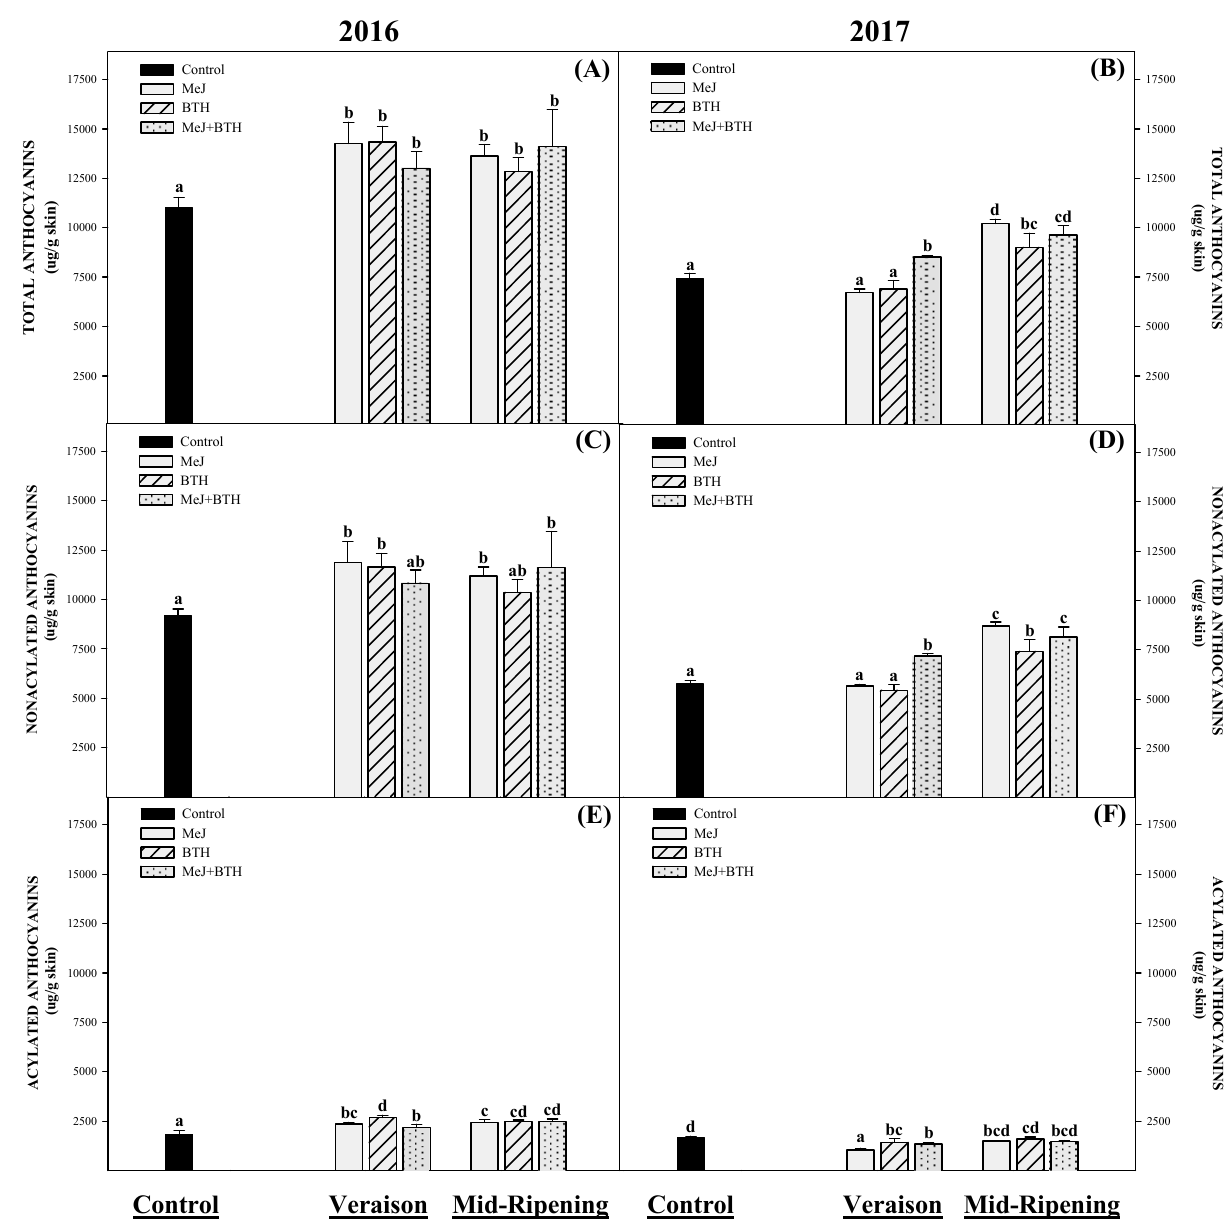
Figure 1. Concentration of anthocyanins measured by HPLC in Monastrell grape berry skin following treatment with MeJ, BTH, and MeJ + BTH applied on two different times: veraison and mid-ripening. Different letters indicate significant differences according to Duncan’s test ( p < 0.05).